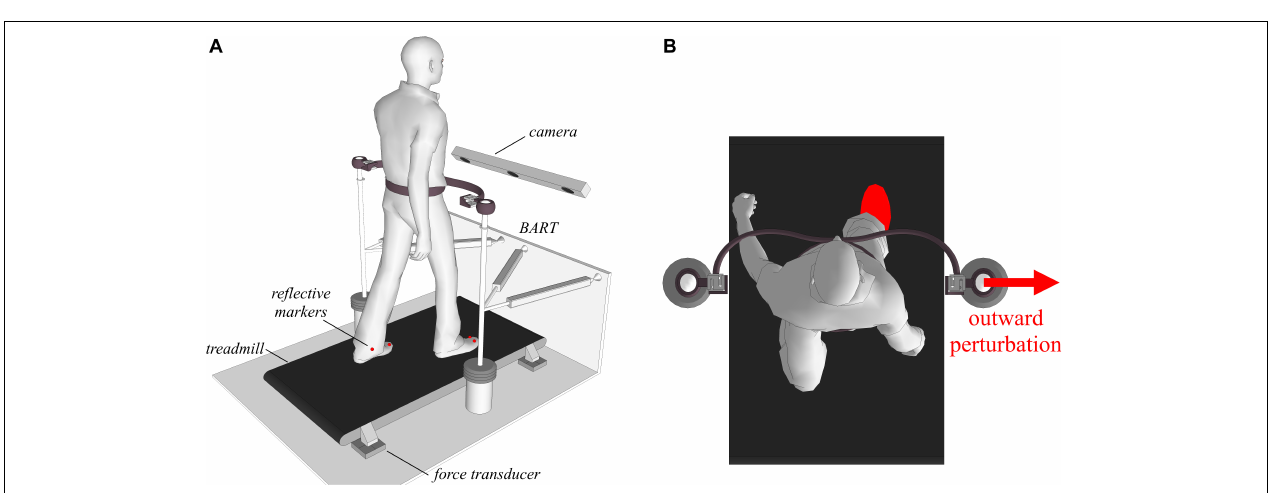
FIGURE 1 | Theoretical considerations on possible interplay between COP, GRF, and COM that produces zero change in the whole-body angular momentum. (A) Frontal plane situation; left side shows the unperturbed situation, right side shows the situation following a perturbing push to the right. (B) Schematic presentation of how the lateral COP can be further displaced if the anterior COP is increased. (C) Sagittal plane situation; left side shows the unperturbed situation, right side shows the situation following a perturbing push to the right.